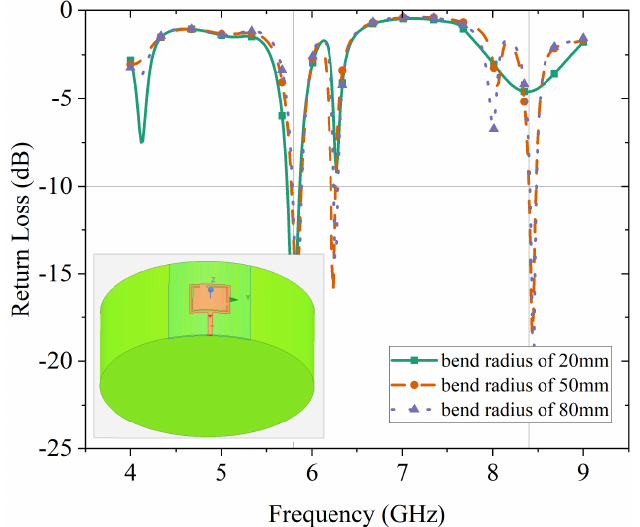
Figure 11. Simulated antenna return loss for different bending